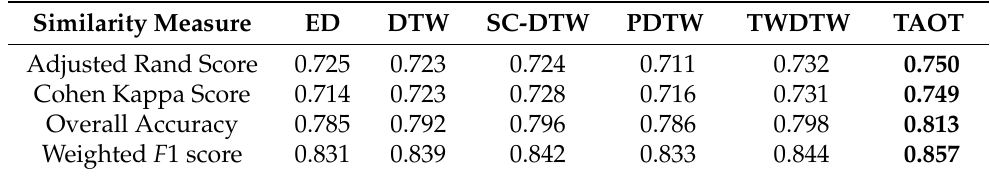
Table 5. Comparison of clustering performance on Poyang Lake dataset with averaged initial cluster centers. The best results are shown in